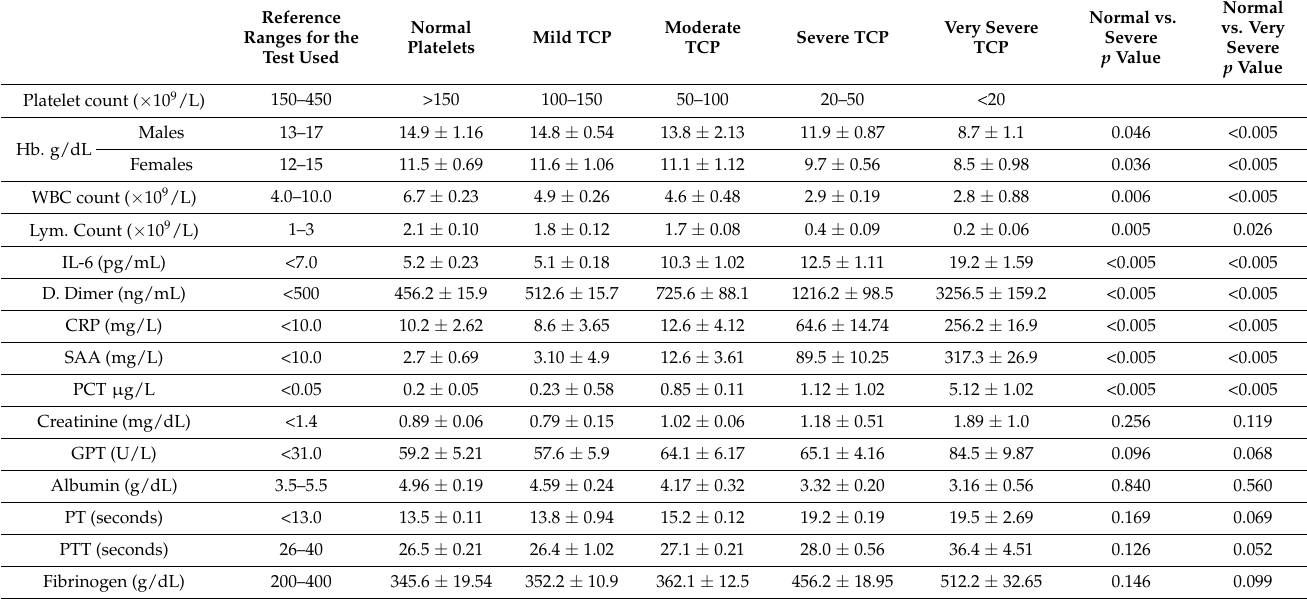
Table 3. Biological markers among different groups of